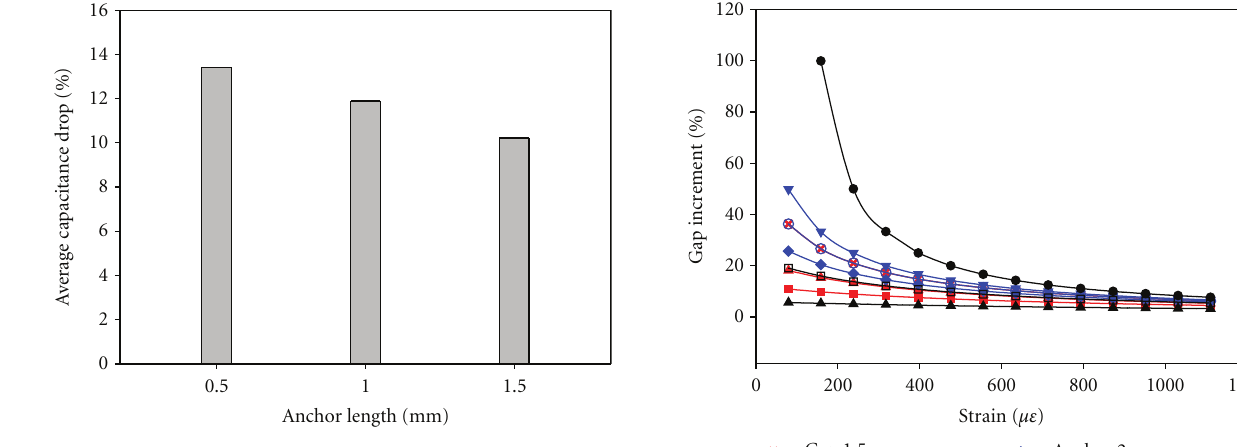
Figure 15: Average percentage of capacitance drop for di ff erent anchor length.